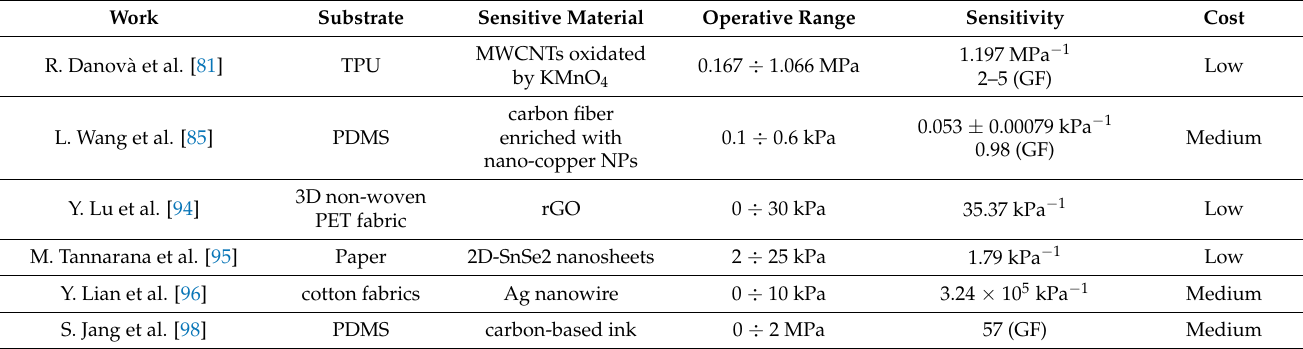
Table 3. Table with summarized the scientific works previously discussed from the point of view of the used substrate and sensing material, operative range, sensitivity and